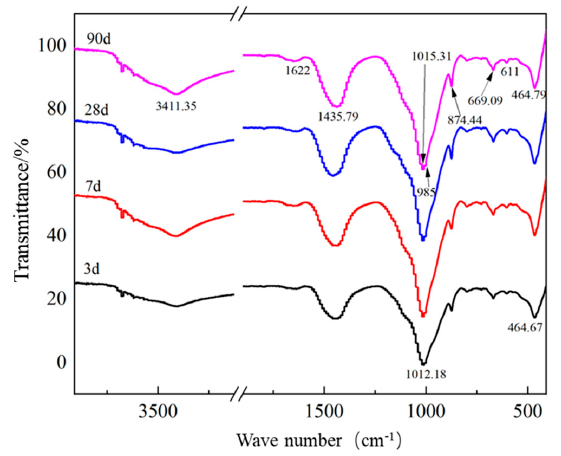
Figure 4. FT − IR spectra of sample 7 at different ages cured at 20 ℃